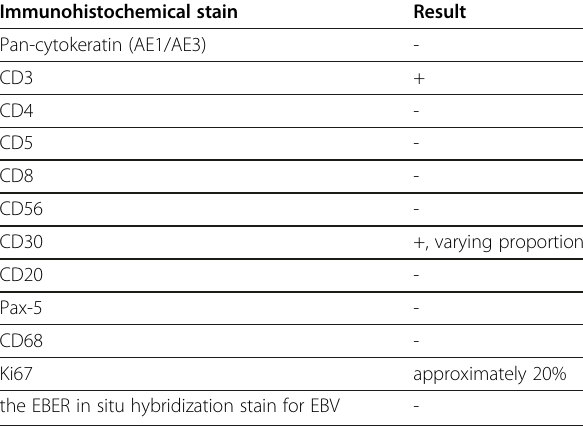
Table 1 Panel of immunohistochemical stains Immunohistochemical stain Result Pan-cytokeratin